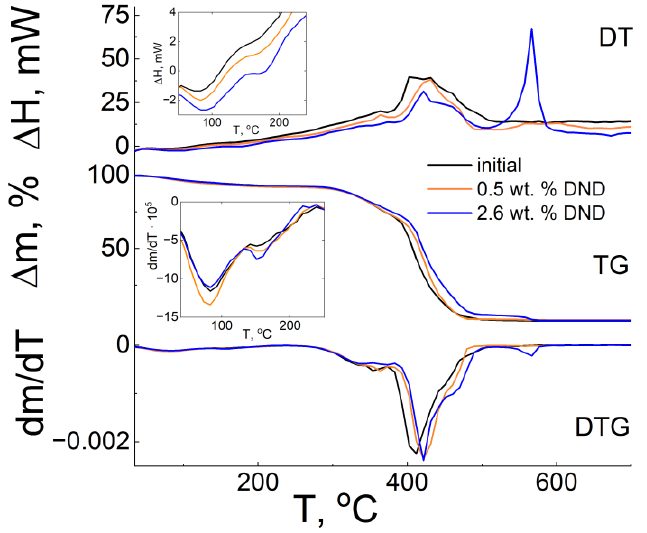
Figure 5. Differential thermal curves of the samples of various composite membranes of the Aquivion ® -type (EW = 897 g-eq/mol) with DND Z+. The moisture content of the samples of different membranes has similar values. This indicates that the addition of DND Z+ does not significantly affect this parameter.